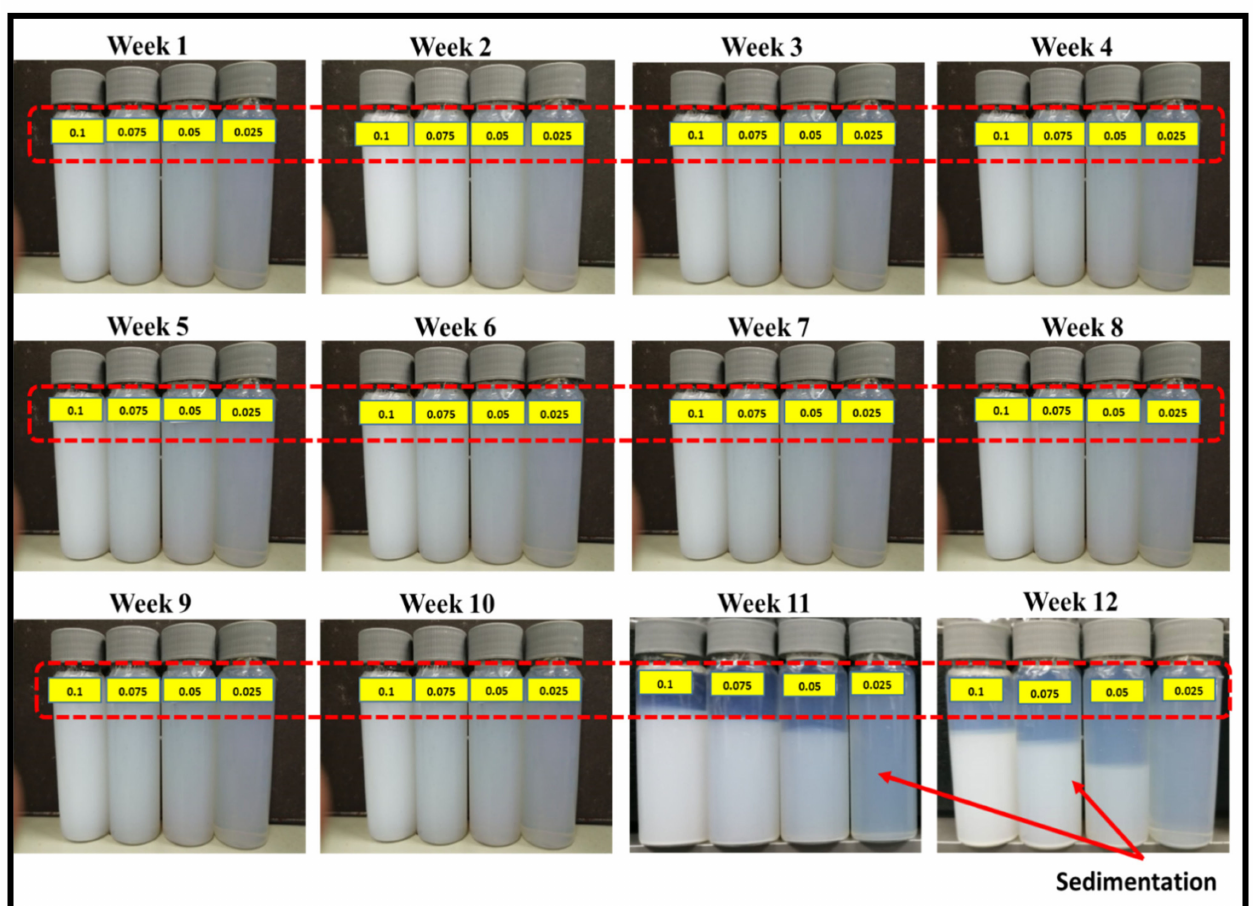
Figure 9. Stability and dispersion of ZnO nanoparticles at different concentrations for 12